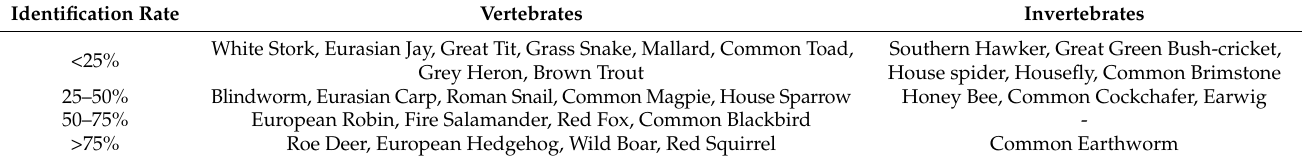
Table 3. The number of students (in%) who were able to identify the respective species at the species level.